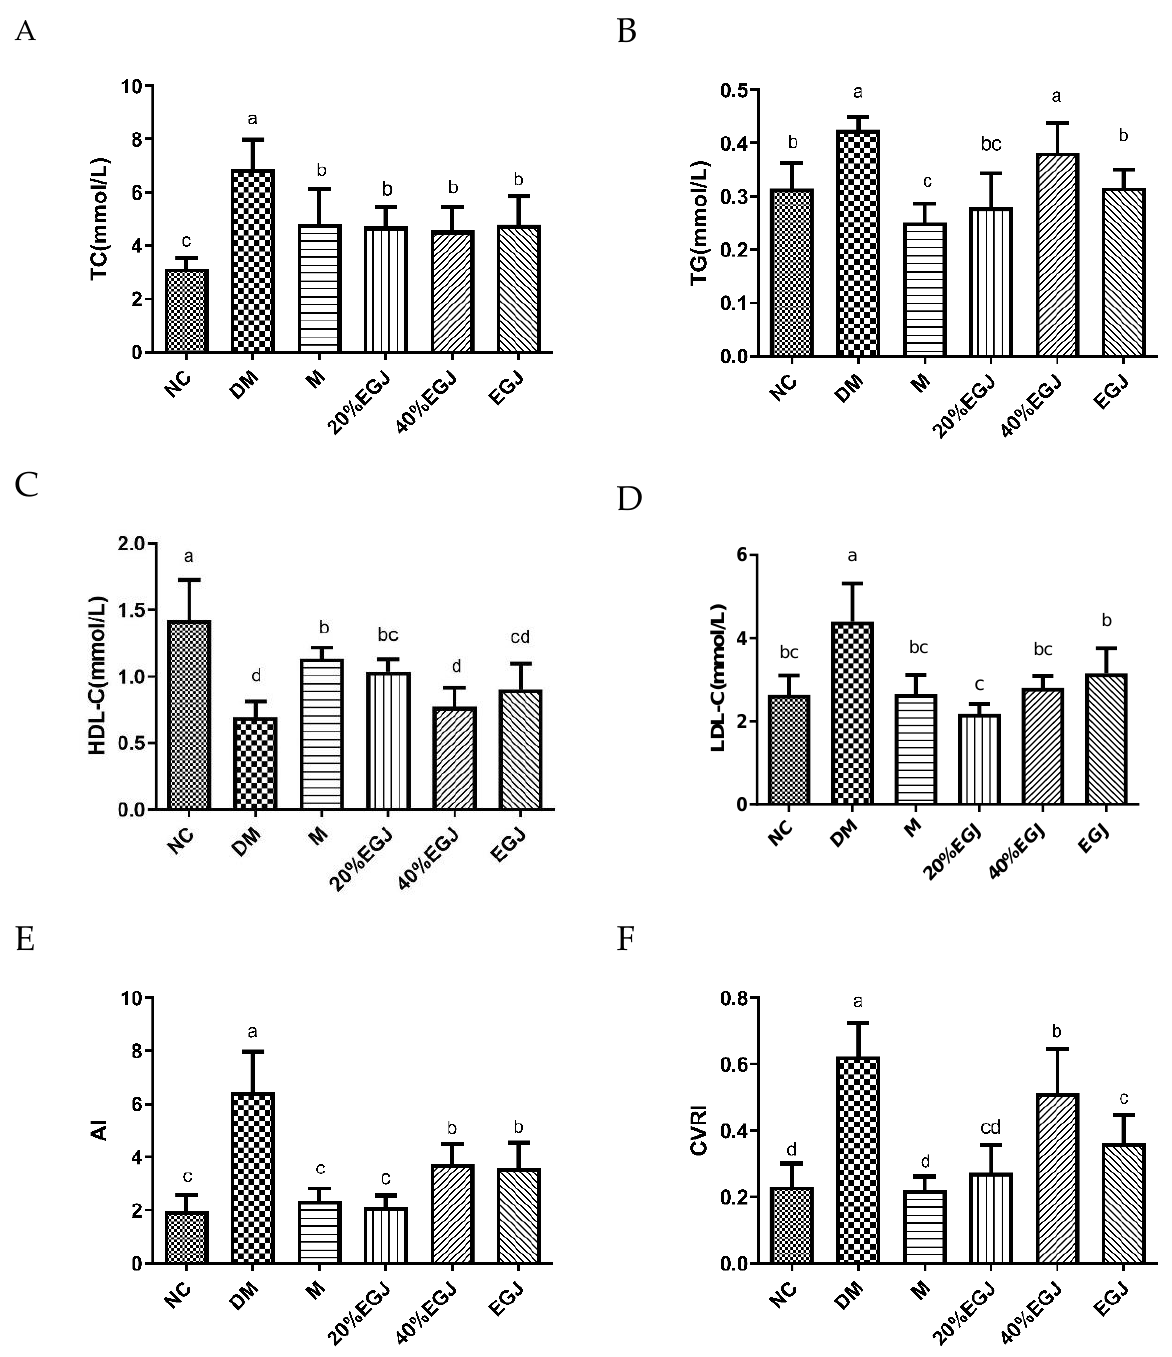
Figure 12. ( A – F ) stands for the TC, TG, HDL-C, LDL-C, AI, and CVRI of the mice in each group, respectively. Note: the data were expressed as the mean ± the SD ( n = 9) and the different letters marked above the bars showed the significant differences ( p <